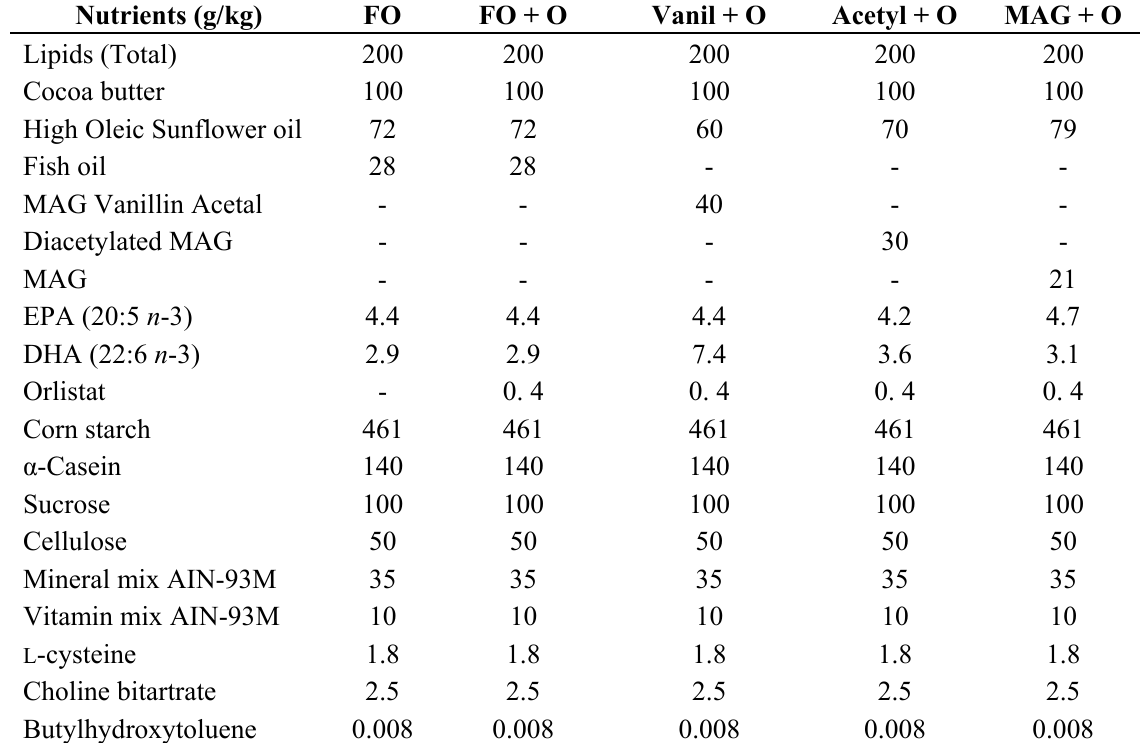
Table 1. Composition of the experimental diets (g/kg of dry